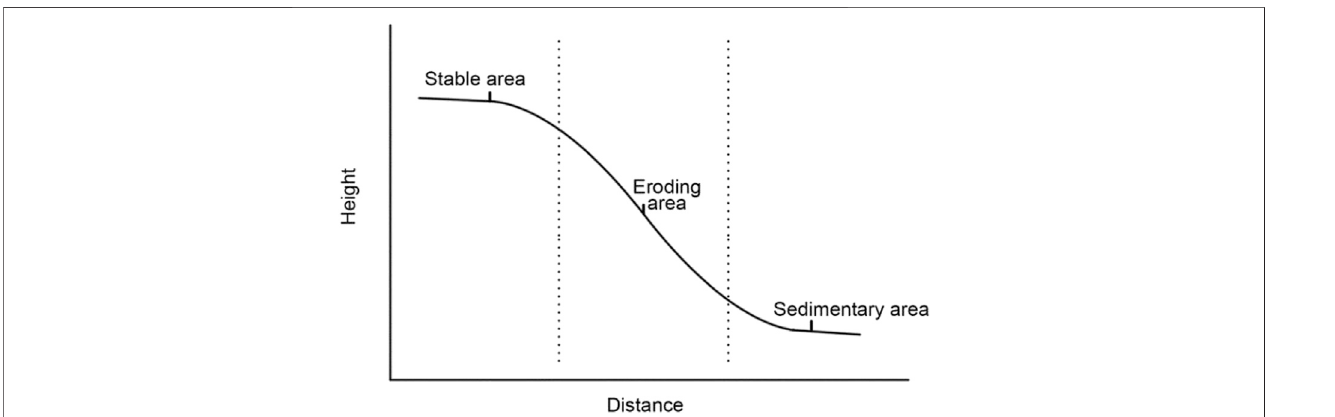
FIGURE 2 | Topographical transect showing stable, eroding, and sedimentary areas. The stable area is on the top of the slope and has a small gradient ( < 5 0 ) and little erosion. The eroding area is in the middle of the slope and has a steep gradient ( > 10 0 ) and strong soil erosion. The sedimentary area is at the bottom of a slope and has a small gradient ( < 5 0 ) and notable sediment